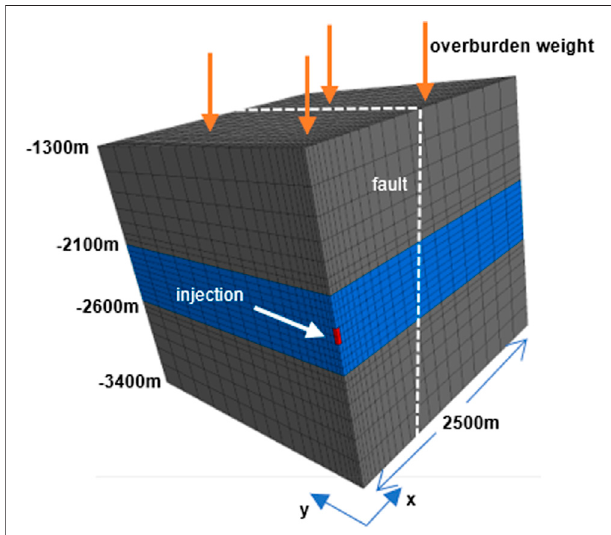
FIGURE 1 | Geometry of the model in FLAC3D-TOUGHREACT. Blue color indicates the carbonate reservoir. Red interval depicts injection interval, dashed white line shows position of fault plane, which intersects reservoir and surrounding rocks.